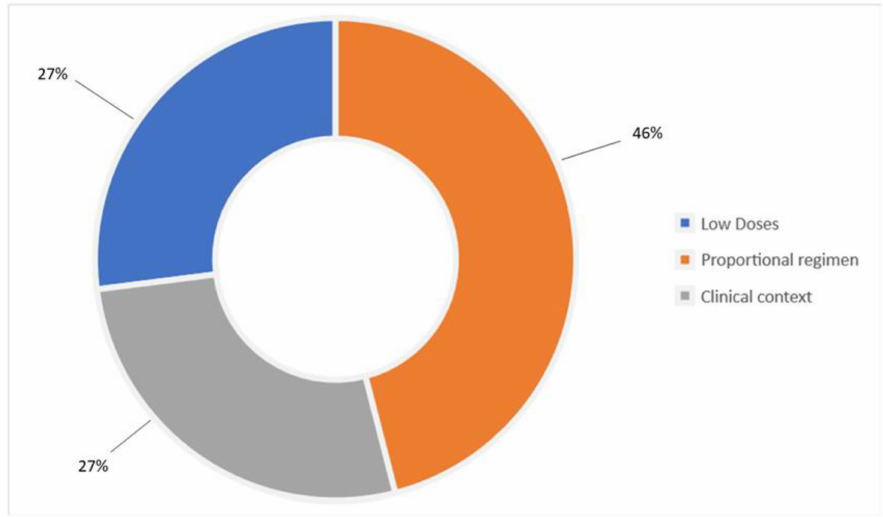
Figure 3. Opioid regimen adopted for breakthrough cancer pain